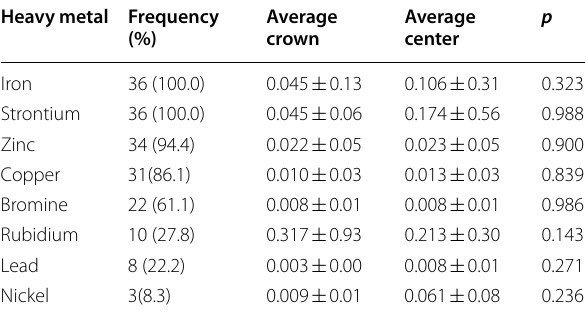
Table 2 Heavy metals and their proportion in relation to calcium at the periphery and nucleus of